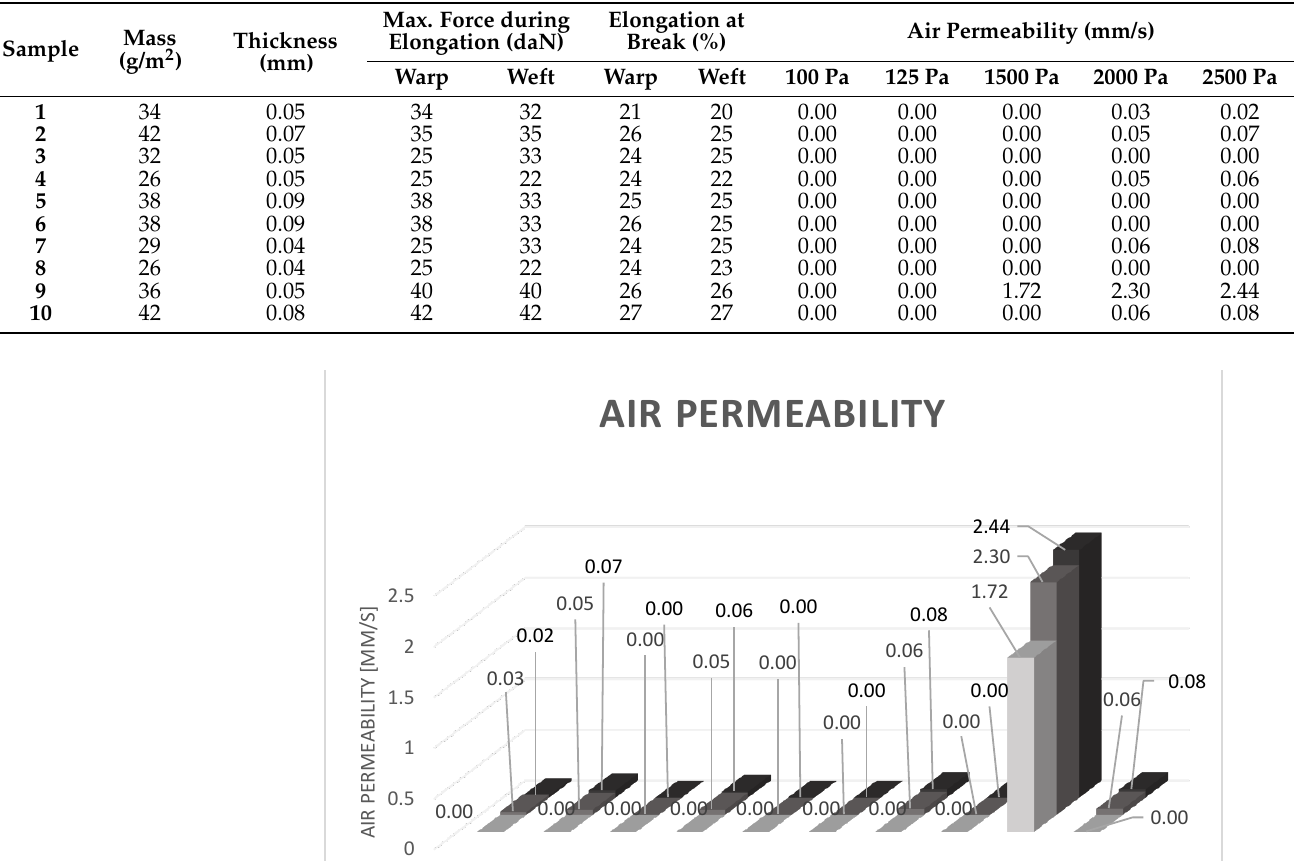
Table 3. Fabric characteristics obtained during the laboratory tests.